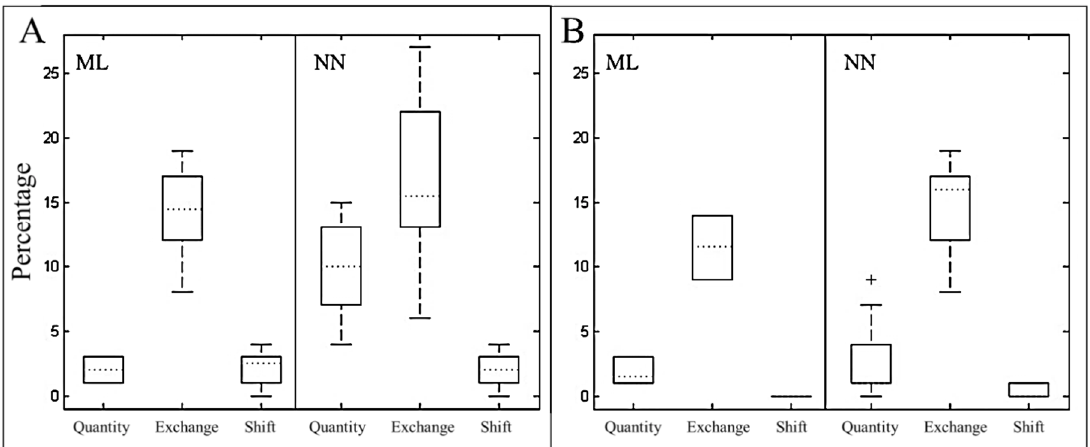
Figure 4. Box-plot showing the quantity, exchange, and shift differences of the image from 2004 ( A ) and 2011 ( B ). ML refers to the Maximum Likelihood and NN to the neural network algorithm. These metrics were calculated taking into account the specific accuracy.